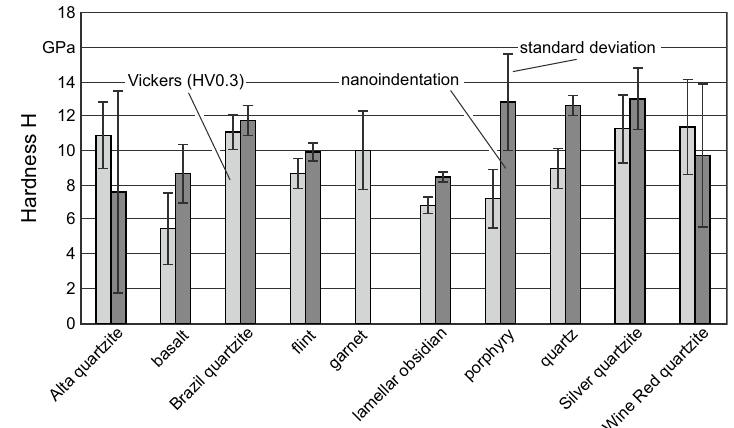
Fig. 6 Hardness of the rocks determined with the help of Vickers hardness tests and